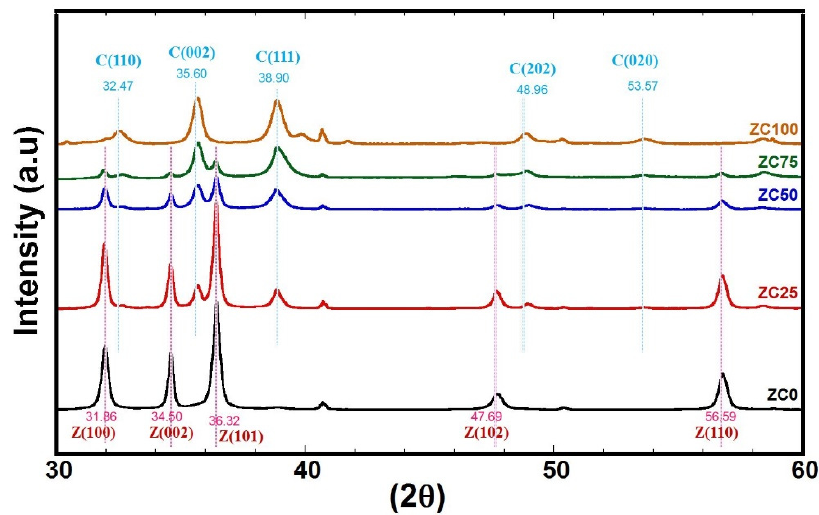
Figure 3. The XRD patterns of the ZC0, ZC25, ZC50, ZC75, and ZC100 samples. Samples ZC25, ZC50, and ZC75 show the peaks corresponding to wurtzite hexagonal zinc oxide and tenorite monoclinic copper oxide with different intensities. However, the intensity of peaks corresponding to wurtzite zinc oxide is decreasing gradually in the samples ZC25, ZC50, and ZC75 with decreasing the amount of zinc precursor in the starting materials. The same can be observed in an opposite way for the monoclinic tenorite and the intensity of copper oxide peaks increases gradually in samples ZC25, ZC50, ZC75 with an increasing copper precursor in the initial compositions (Table 1) [2,26,48]. There are no peaks detected by XRD for Zn metal, Cu metal, or any other compounds which indicates the high purity of formed ZnO-CuO nanocomposites. In addition, there is no observed shift in the corresponding peaks of either ZnO or CuO, which indicates the het- erostructure formation of ZnO-CuO and no incorporation [49].